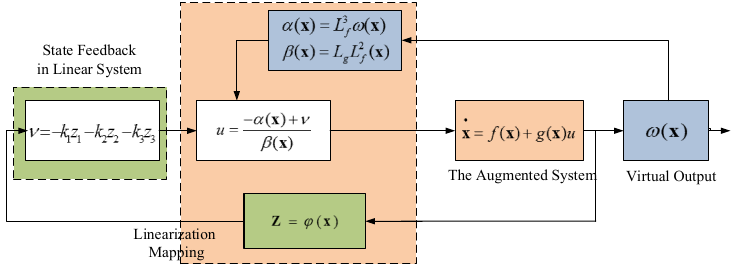
Figure 7. Augmented state ‐ space feedback linearization control strategy.